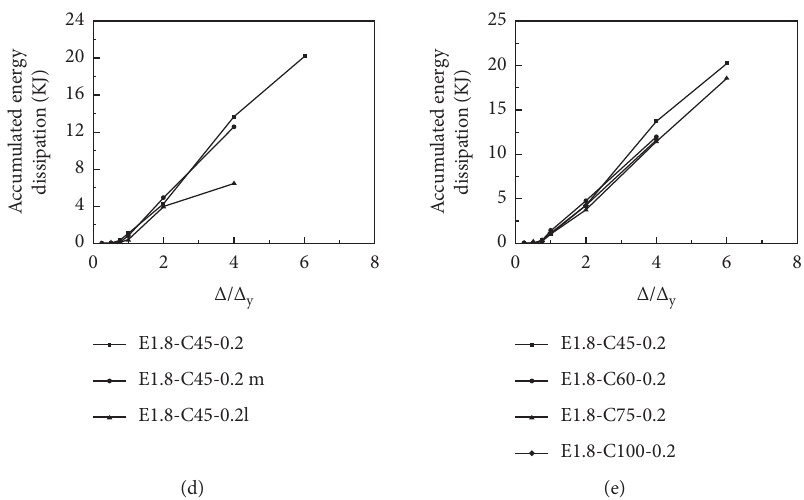
Figure 12: Accumulated energy dissipation of test specimens. (a) Variation of aspect ratio. (b) Variation of axial compression ratio. (c) Variation of bending axis. (d) Variation of slenderness ratio. (e) Variation of concrete strength.